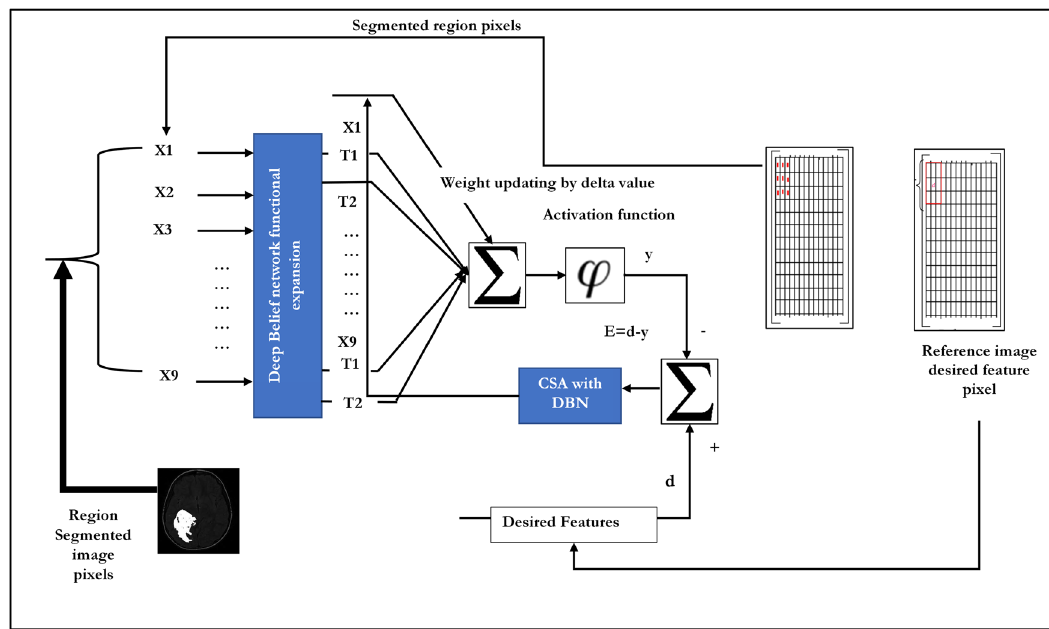
Figure 4: Structure of CSA - DBN feature extraction